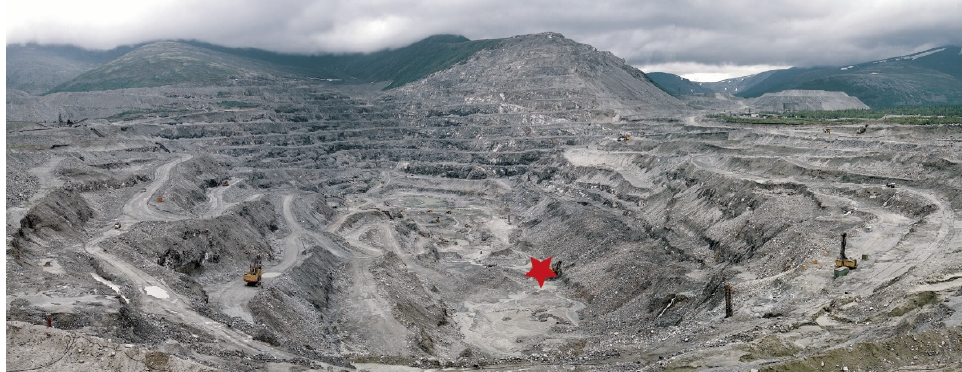
Figure 1. Koashvinskii quarry (locality of natrophosphate marked by the star).